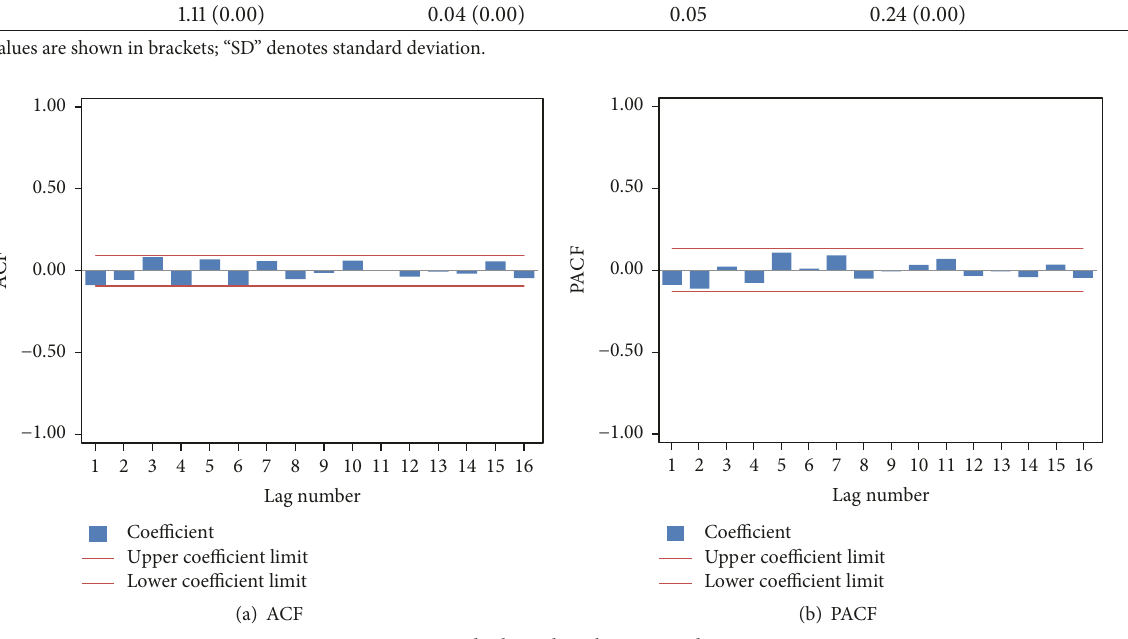
Figure 6: Residuals analysis by ACF and